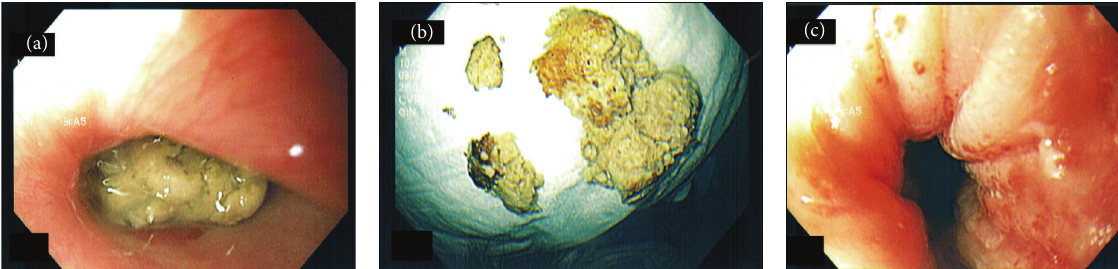
Figure 1: (a) Foreign body impacted in the proximal esophagus. (b) Foreign body after being removed from the esophagus. (c) Inflammation seen at the site of the removed foreign body in the esophagus.